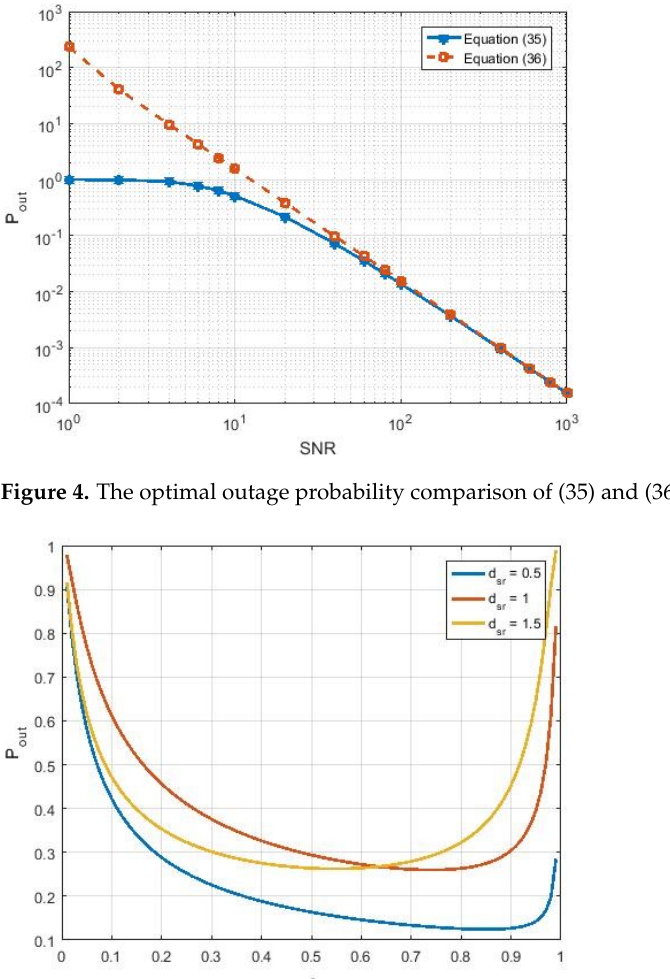
Figure 3. The optimal outage probability comparison of (26) and (27) with different SNR.